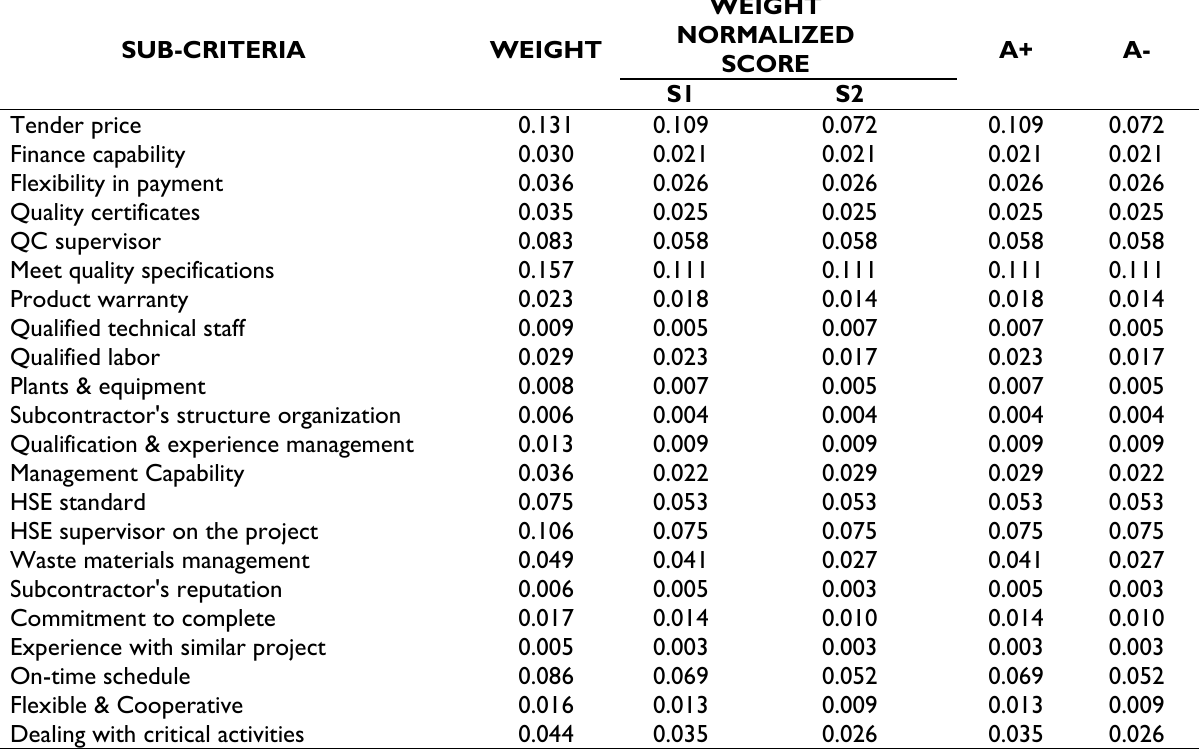
Table 4. Subcontractor weighted normalization matrix